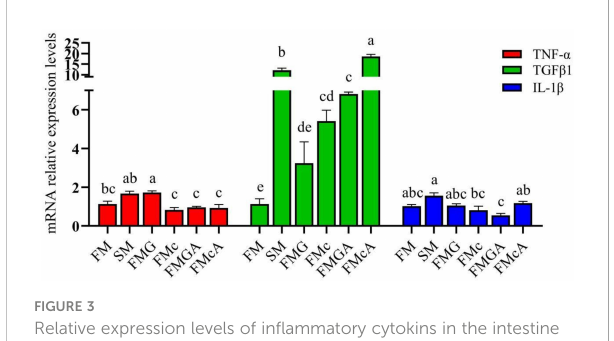
FIGURE 3 Relative expression levels of in fl ammatory cytokins in the intestine of mirror carp at different treatments fed with diets containing fi shmeal (FM), soybeans meal (SM), glycinin (FMG), B-conglycinin (FMc), AKG+B-conglycinin (FMcA) after eight weeks. TNF-a, tumor necrosis factor alfa; TGF-B1, transforming growth factor beta; IL-1B, interleukin-1 beta. Data are presented as means + SE, (n = 3). a, b, c Mean values with different letters were signi fi cantly different (P<0.05).